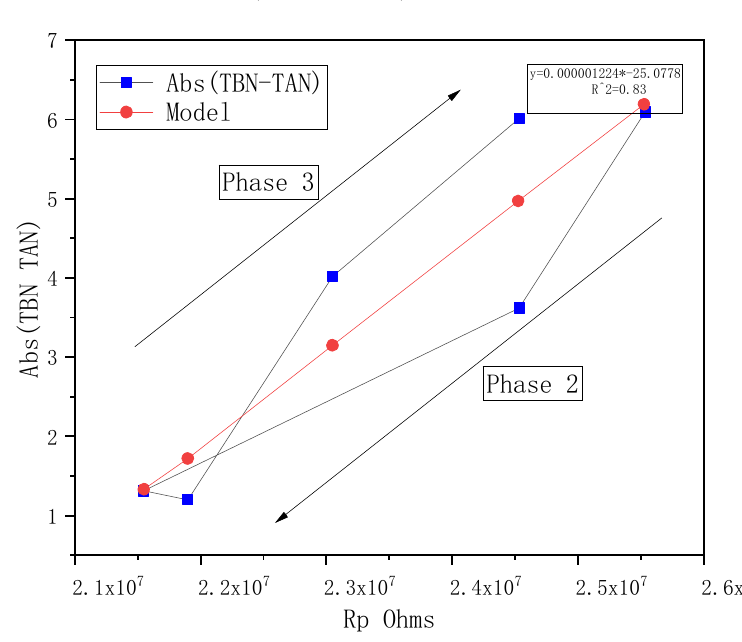
Figure 19. Correlation between Abs (TBN-TAN) and Rp measurements at 100 °C. Simultaneous resistivity measurements do not allow a precise direct measurement of TBN and TAN values. However, resistivity monitoring allows a prediction of |TBN − TAN| < 0, TBN > TAN) and Phase 3 (when ∂ Rp > 0, and detection of Phase 2 (when ∂ Rp ∂ t ∂ t TAN > TBN). As stated previously, Phase 3 corresponds to a level of oil degradation for | TBN-TAN | =1 . 224 × 10 -6 .R + 25.0778 (44) which an oil change is P